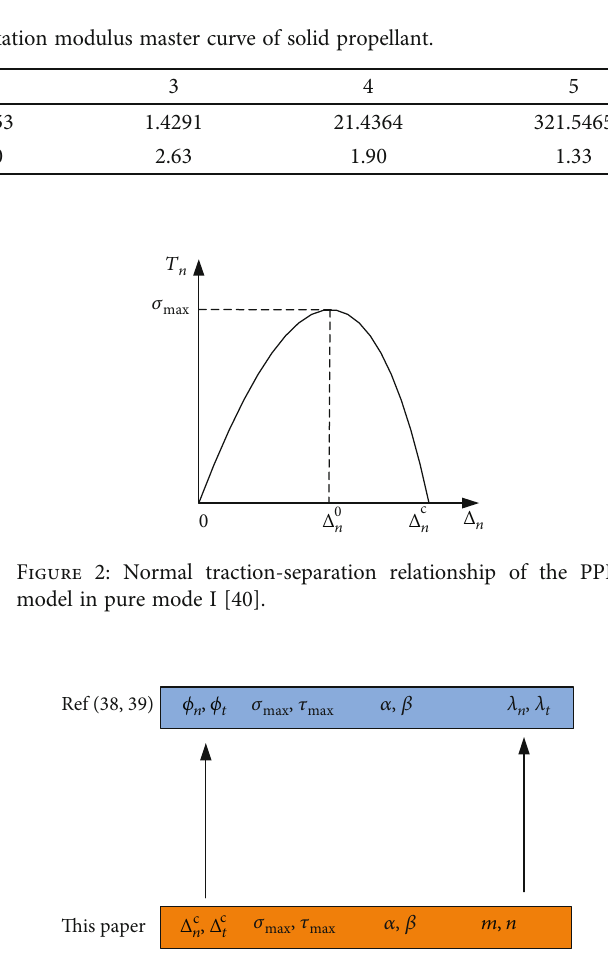
Figure 3: Di ff erence of the control parameters between Ref. [38, 39] and this